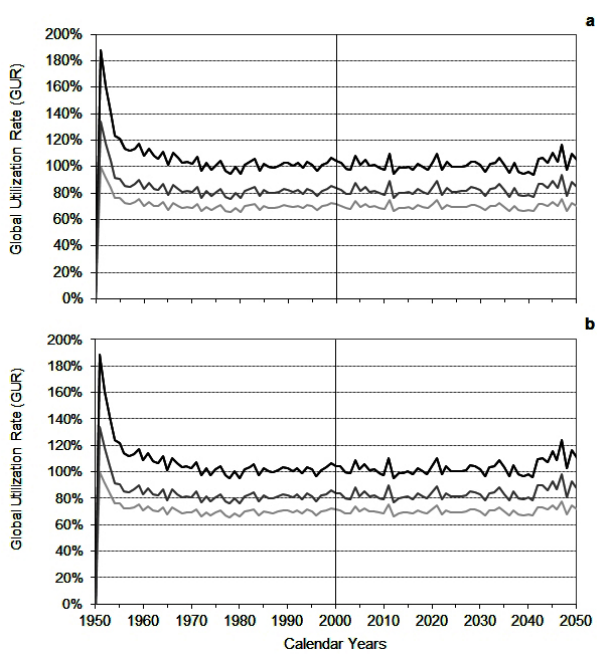
Fig. 4 . Global utilization rates (GUR) of produced forage for the three pastures and the two Intergovernmental Panel on Climate Change Special Report Emissions Scenarios (IPCC-SRES 2000) climate change scenarios: (a) B2 and (b) A1FI. Pastures are Les Cluds Sud (EWP:light grey curve), Les Planets Milieu Est (MWP:dark grey curve), and Les Planets Ouest (IWP: black